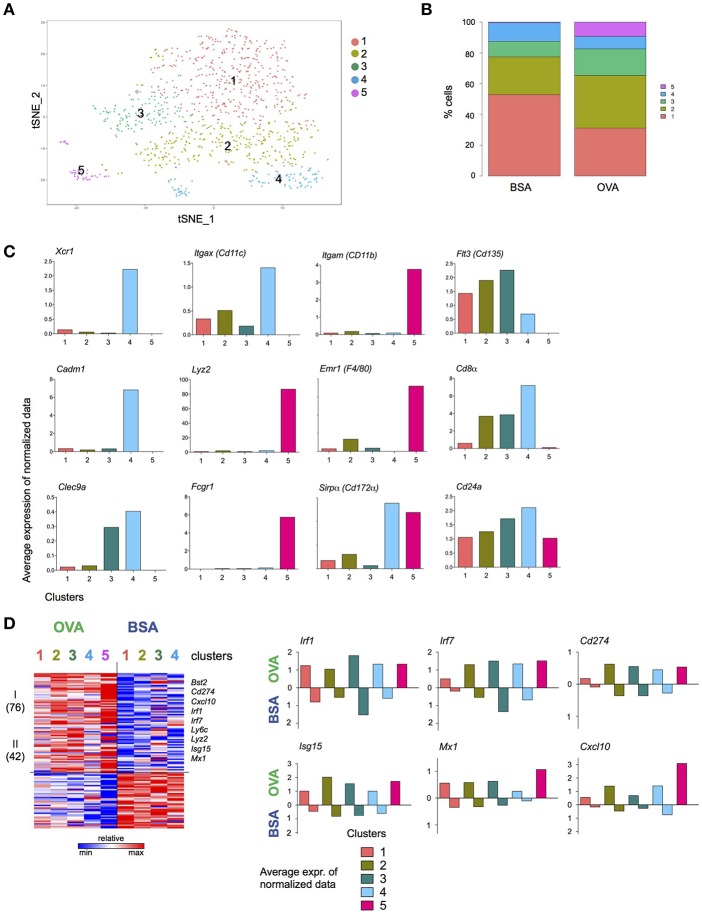
T cell interacting DC signature revealed by single cell transcriptome analysis. Experimental lineup is represented in Figure 4A. (A) 476 (OVA/CpG) and 496 (BSA/CpG) NP+ DC were analyzed and portioned into 5 clusters. (B) OVA and BSA carrying DC contribution to each cluster. (C) Examples of cDC1 and moDC genes is shown as the log average expression of normalized data in each cell cluster. (D) (Left) Heatmap represents Z scores of log average expression of normalized data of 118 differentially expressed genes (OVA vs. BSA) separated into 2 gene clusters by k-mean method. (Right) Average expression of normalized data for representative genes Isg15, Irf1, Cxcl10 and Mx1. Gene expression of both OVA- and BSA-carrying DC is shown separated. Cluster is not shown due to lack of cells.